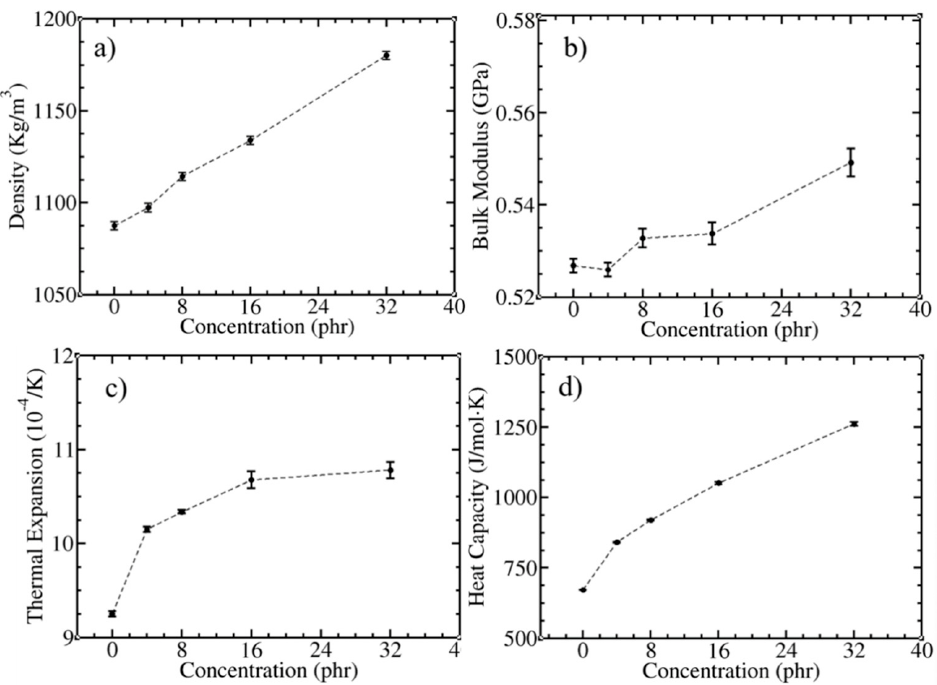
Figure 1. ( a ) Density, ( b ) bulk modulus (Equation (3)), ( c ) thermal expansion (Equation (1)), and ( d ) heat capacity (Equation (2)) of cis -PI and C 60 composites as a function of C 60 concentration.